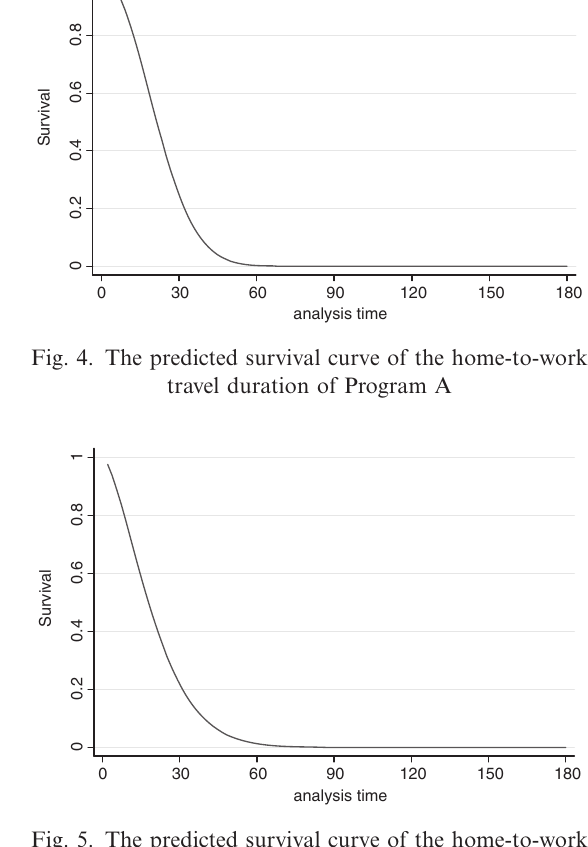
Fig. 5. The predicted survival curve of the home-to-work travel duration of Program B